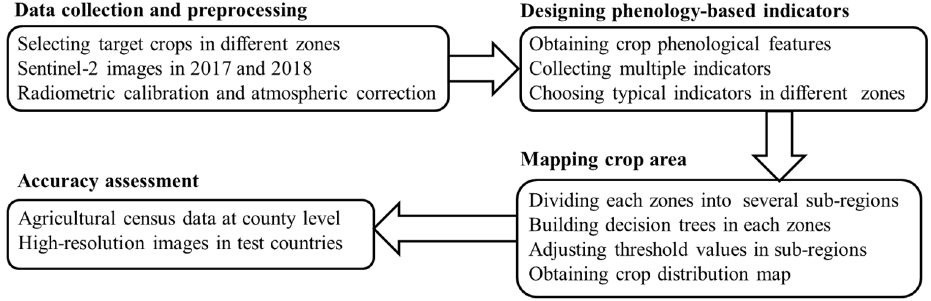
Figure 2. Overview of the methodology in the crop pattern mapping research.